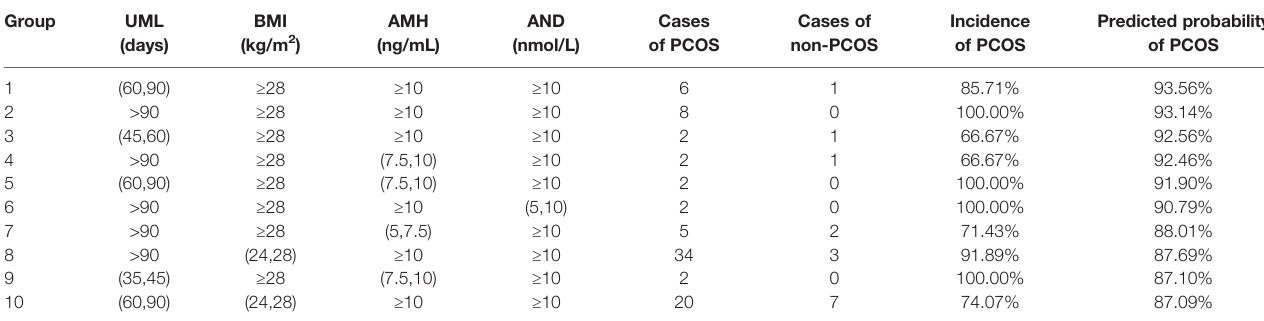
TABLE 6 | The 10 groups of women with highest predicted probability of PCOS. Group AND